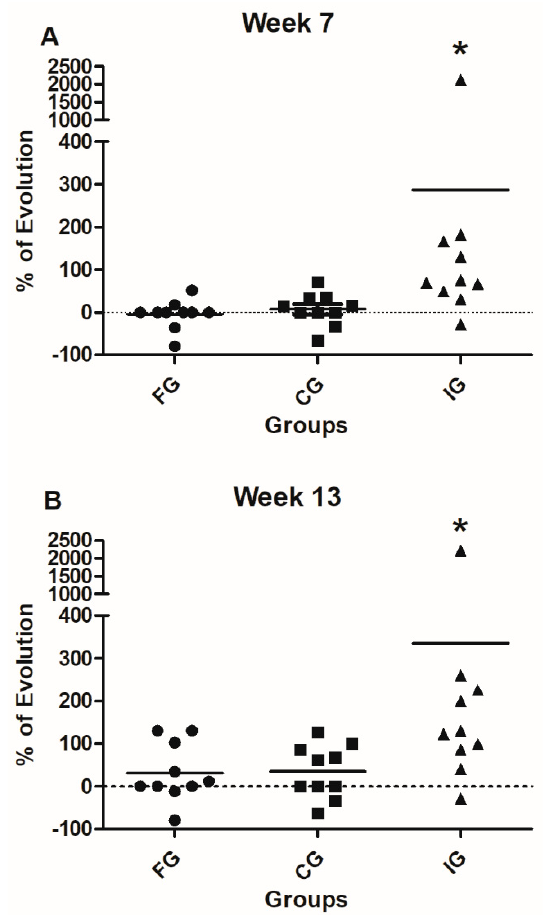
Figure 5. Percentage of evolution (GMFD, standing) of FG, CG, and IG. ( A ) The evolution from the baseline to the seventh week shows a significant improvement of standing ability in IG in comparison with the one observed in FG and CG patients. * p = 0.025, Kruskal Wallis test. ( B ) The evolution from the baseline towards the 13th week shows significant improvement in standing ability of IG compared to FG and CG patients. * p = 0.03, Kruskal Wallis test. Black line represents the mean of 10 patients. When the walking parameter was analyzed, the evolution from the baseline to the seventh week did not present any significant advantage for any of the groups (Figure 6; p = 0.15, Kruskall Wallis followed by Dunn’s test). Nevertheless, in the evolution observed up to the thirteenth week, IG patients presented a significant improvement, compared with FG and CG patients ( p = 0.03, Kruskall Wallis followed by Dunn’s